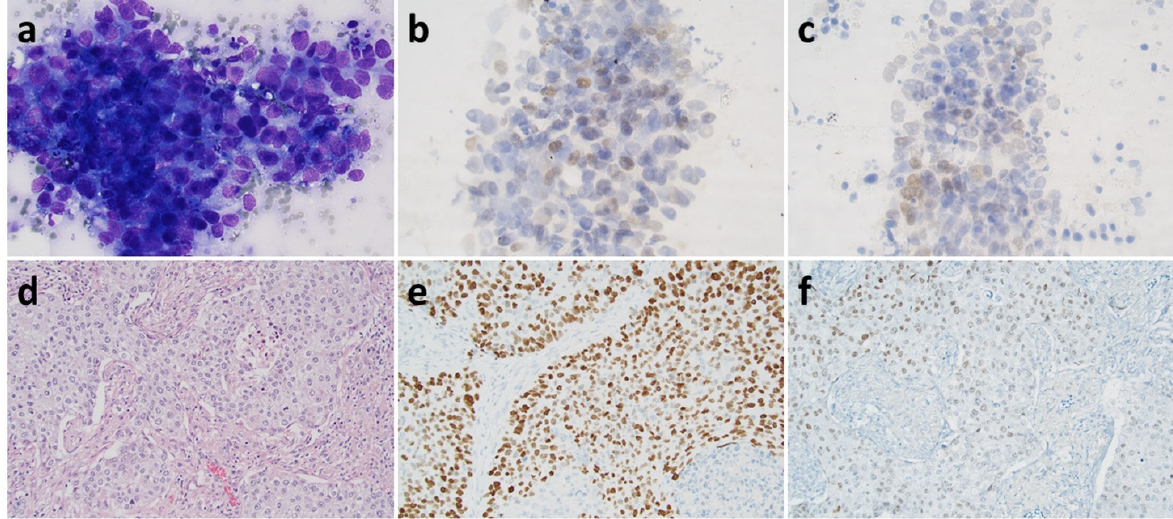
Figure 1. A case diagnosed as adenocarcinoma on pre-surgical cytology ( a – c , ×40 objective) based on TTF-1 positivity with clone SPT24 (no squamous marker included) while the diagnosis proved to be squamous cell carcinoma on resection ( d – f , ×20 objective) with focal positivity with TTF-1 clone SPT24. Staining with ( a ) may-grünwald-giemsa, ( b , c , f ) TTF-1 clone SPT24, ( d ), hematoxylin-eosin, ( e ) p40.